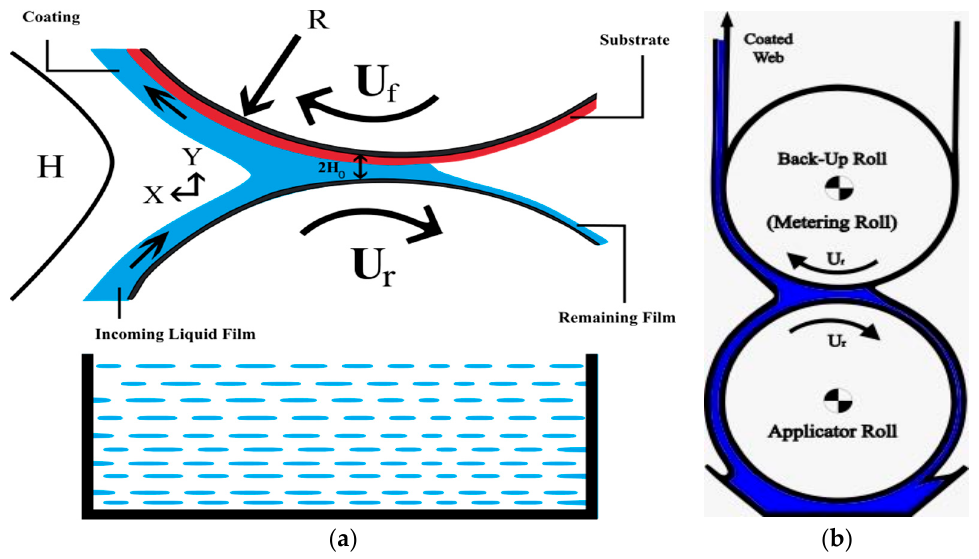
Figure 1. ( a ) Schematic representation of the reverse roll coating process, ( b ) reverse roll operation.